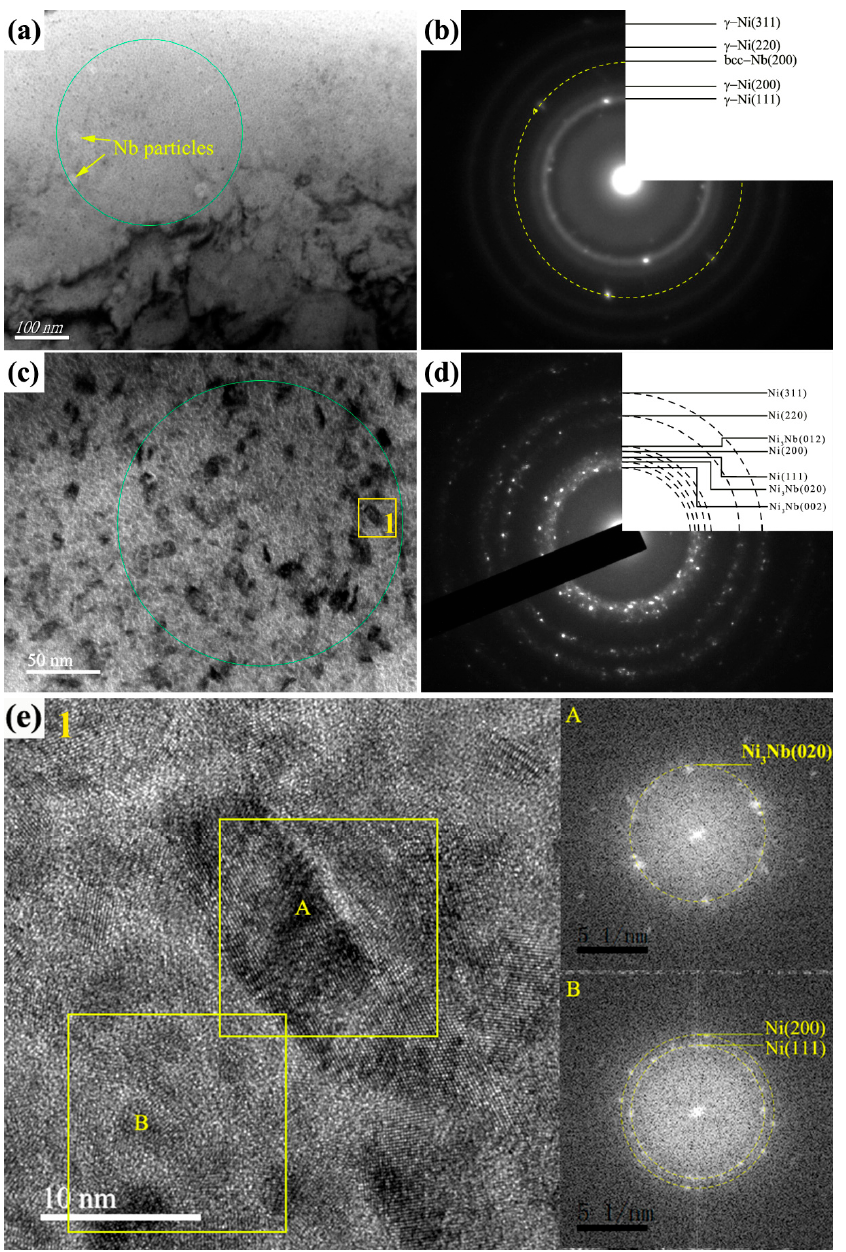
Figure 5. TEM images and SAED patterns of the 10-pulsed Ni-Nb coating. ( a ) The Ni particles and Ni 3 Nb particles; ( b ) the SAED pattern of ( a ); ( c ) higher magnification image of the Ni and Ni 3 Nb particles; ( d ) The SAED pattern of ( c ); ( e ) The HRTEM image of region 1. Figure 6a,b give the bright field and HRTEM images of 20-pulsed Ni-Nb layer. Alt- hough the SAED of 20 pulsed samples indicates that the matrix was composed of the amorphous phase (Figure 4b), the very fine clusters crystals with about 3 nm in size were